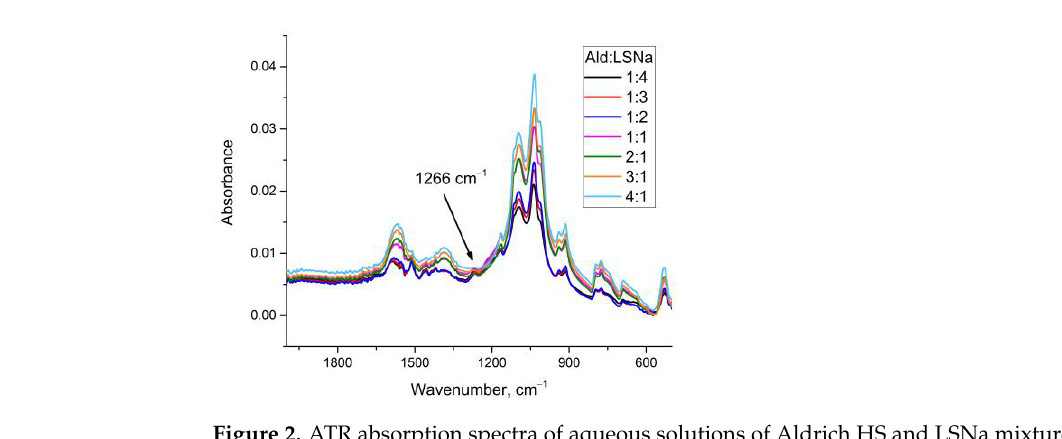
Figure 4. ATR absorption spectra of centrifuged aqueous solutions of sodium lignosulfonate, po- tassium humate Powhumus (Pow), and their 1:1 mixture, with concentrations of 50 g/L. As mentioned above, the characteristic bands of lignosulfonate at 1266, 1192, and 1042 cm −1 are complex [83] and may overlap with bands of intermolecular interactions in HS. Nevertheless, as lignosulfonates have a more definite functional - group composition and thus give rise to narrower and more intense bands (Figure 1), we can determine LS against the background of humates. 3.3. Band Processing The bands of the ATR spectra of lignosulfonate solutions are resolved (Figure 1), and band integration does not affect the quantification result. However, peak integration is essential for mixtures of lignosulfonate with humate since the LS and HS bands overlap (Table 1 and Figure 4). Therefore, even though a mixture purified from silicate has no distinct bands in the region of 1300–1000 cm −1 , humate still contributes to the total spec- trum with broadbands in the entire range and can lead to a significant error in quantify- ing lignosulfonate. Therefore, when quantifying lignosulfonate, it is strictly necessary to correct it for the background content of HS. Upon preliminary studies, we selected three approaches towards this correction. They are Method 1 (peak intensity relative to hori- zontal baseline, in two variants) and Method 2, taking into account the humate concen- tration without a baseline correction (full peak height), Section 2.2.